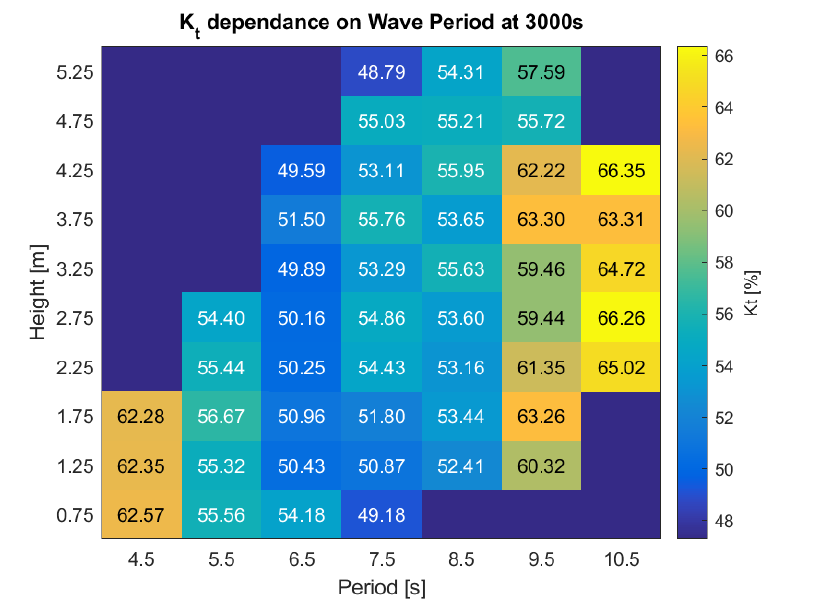
Figure 7. The transmission coefficient ( K t ) matrix for each wave condition calculated by WEC–Sim. The WEC absorbs the most power at a period of 6.5 s. The K t values are period-dependent and were averaged along each period to simplify the model.